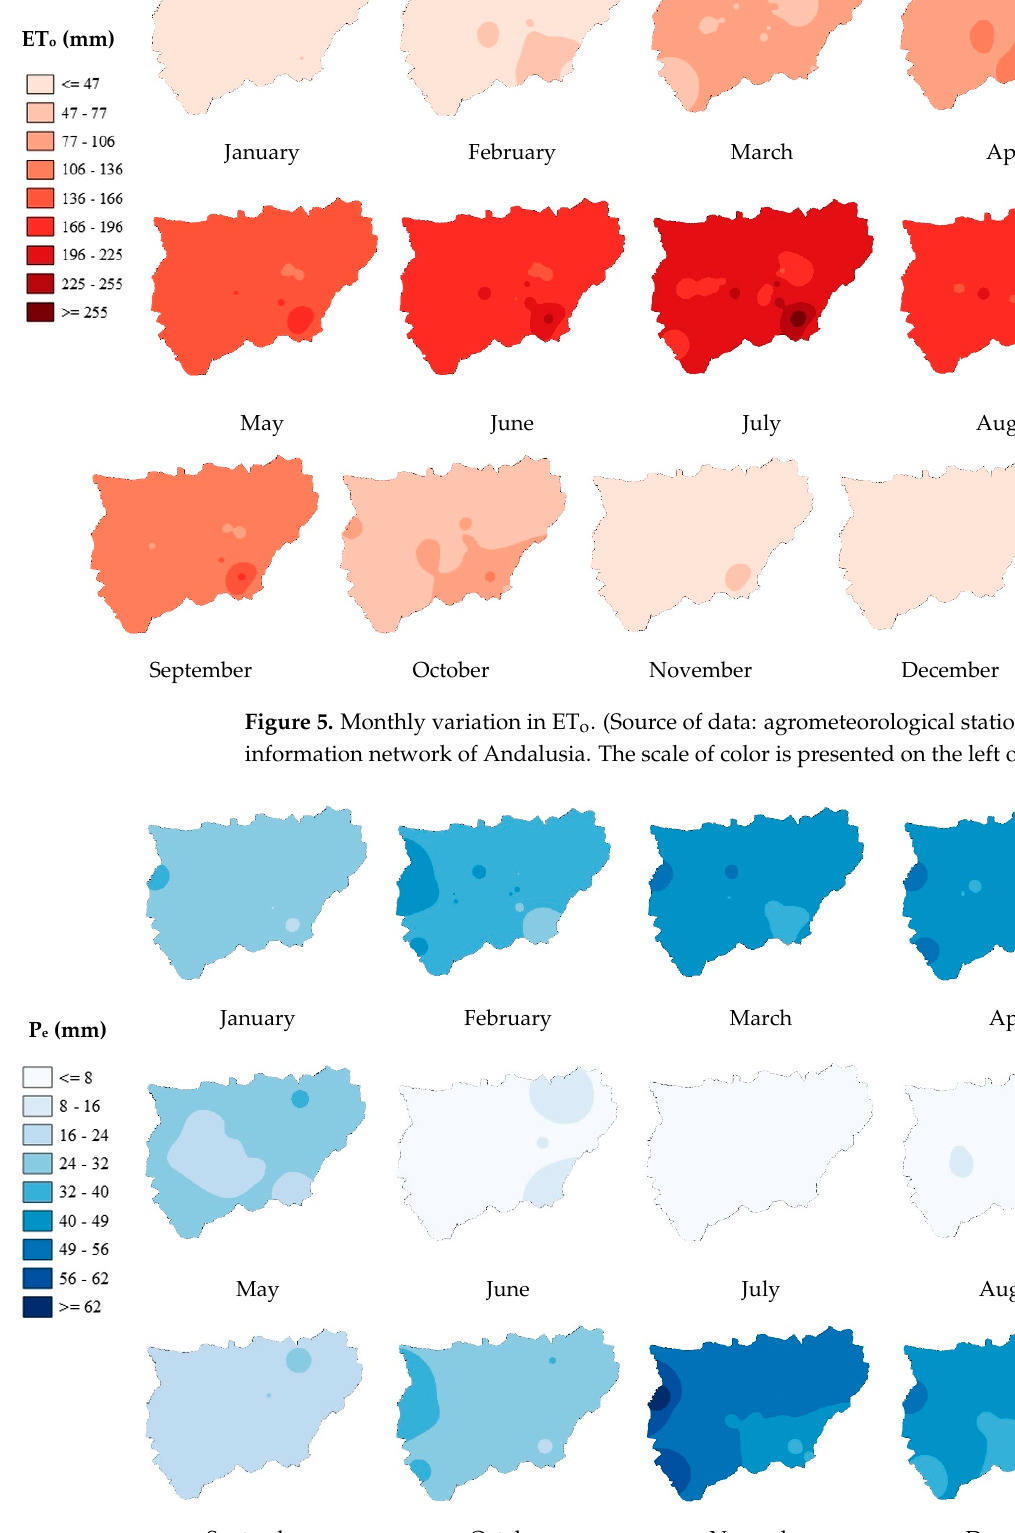
Figure 6. Monthly variation in Pe. (Source of data: agrometeorological stations of the agroclimatic information network of Andalusia. The scale of color is presented on the left of the figure).